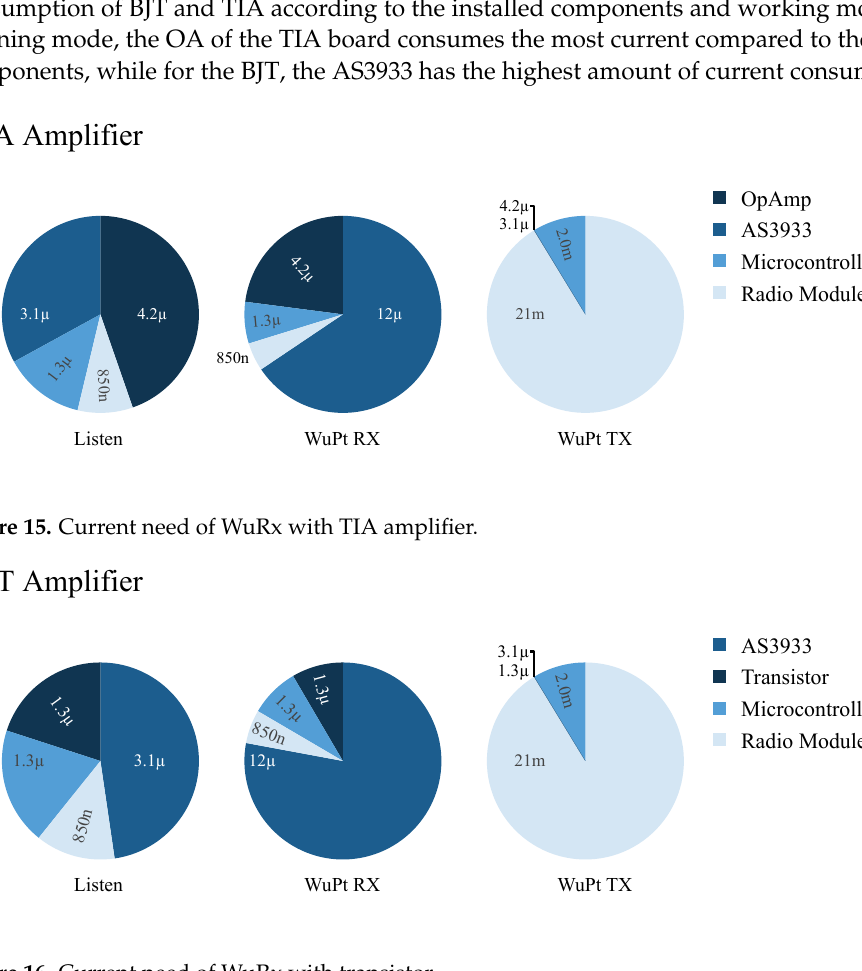
Figure 16. Current need of WuRx with